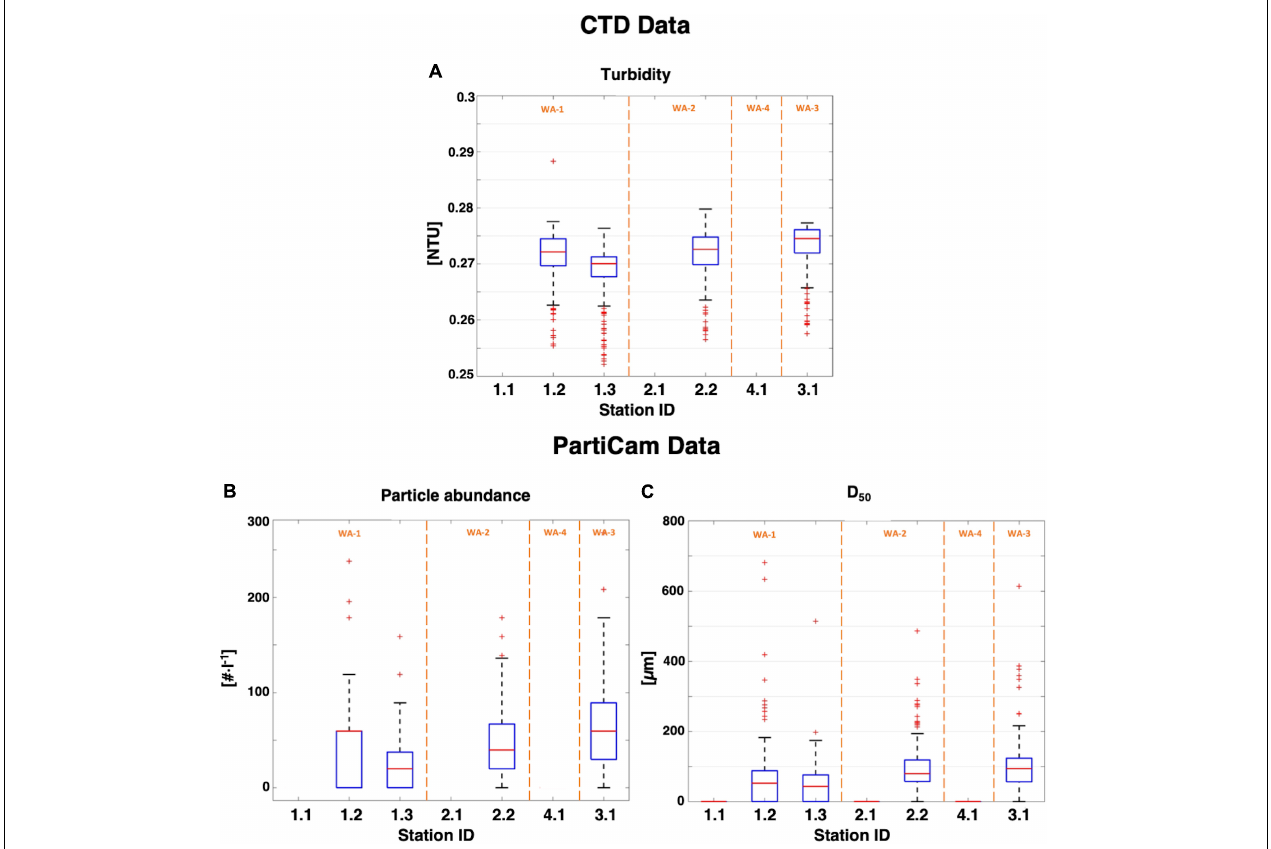
FIGURE 7 | Box plots of all CTD and PartiCam data from the whole water column vs. sampling stations. (A) Turbidity measured with the CTD. (B) Particle abundance and (C) median diameter values measured with the in situ PartiCam system. Upper and lower boxplot whiskers represent the maximum and minimum values of the dataset. Interquartile range is shown as the blue box (50% of the dataset). Red line indicates the median value and red “+” are outliers. Working areas are shown in